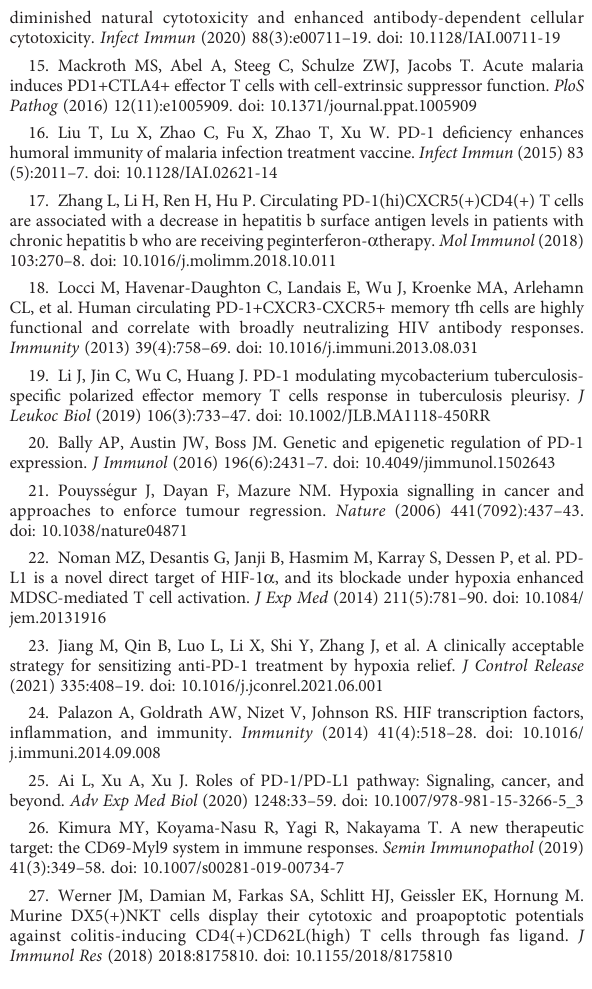
The gating strategy used for all FACS